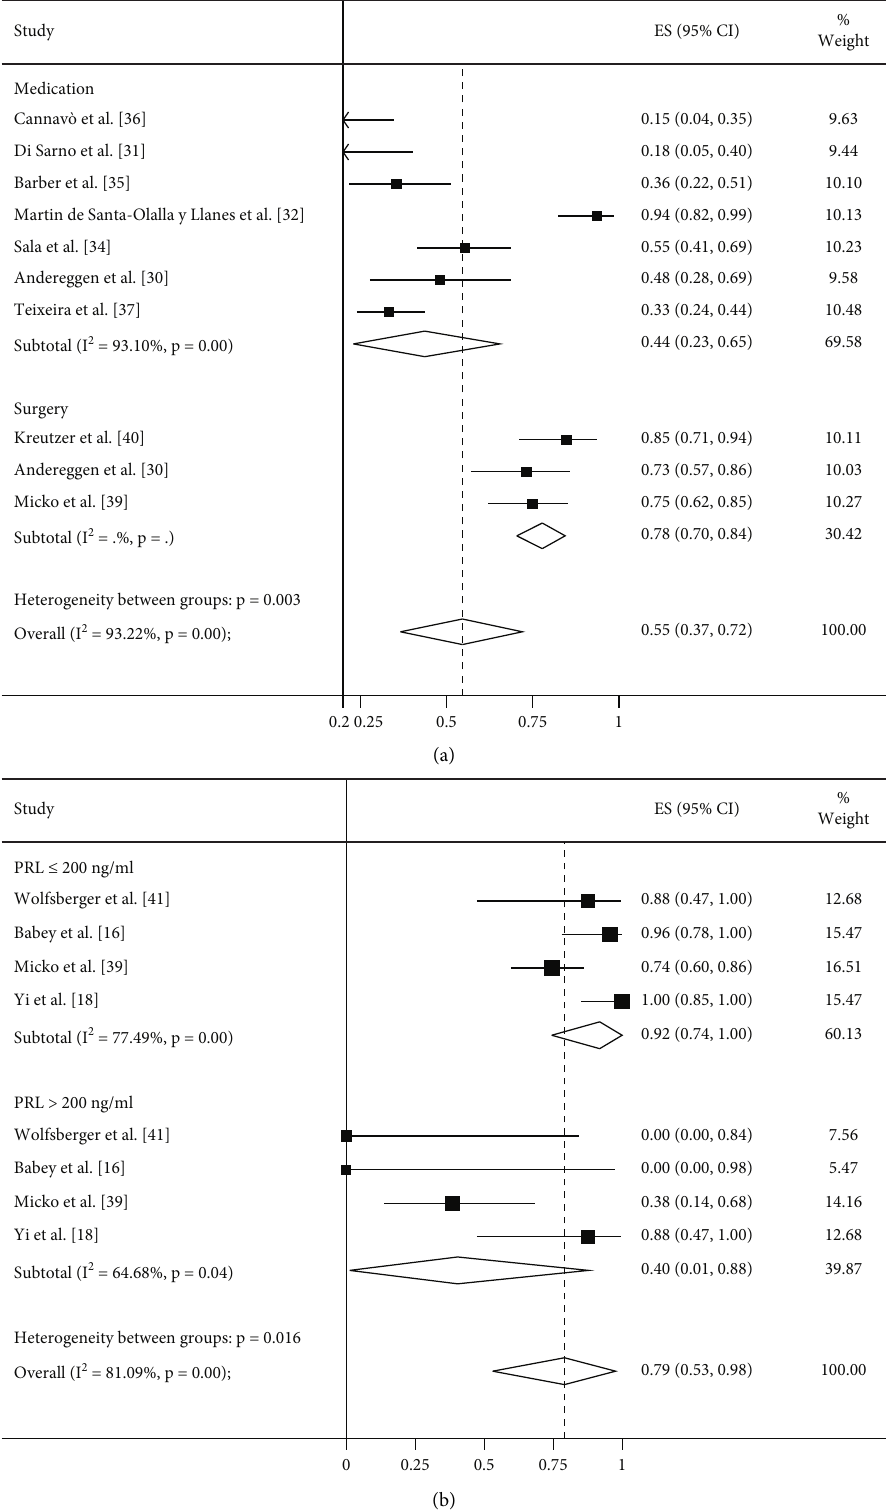
Figure 4: Meta-analysis of remission rates comparing surgery and medical treatment in microprolactinomas after treatment withdrawal and the results of subgroup analysis: (a) the remission rate was achieved in 78% of patients treated with surgery and 44% of patients treated with DAs ( P � 0 . 003) after treatment withdrawal and (b) the remission rate was achieved in 92% of patients with preoperative PRL level of ≤ 200ng/ml and 40% of patients with preoperative PRL level of > 200ng/ml ( P � 0 .